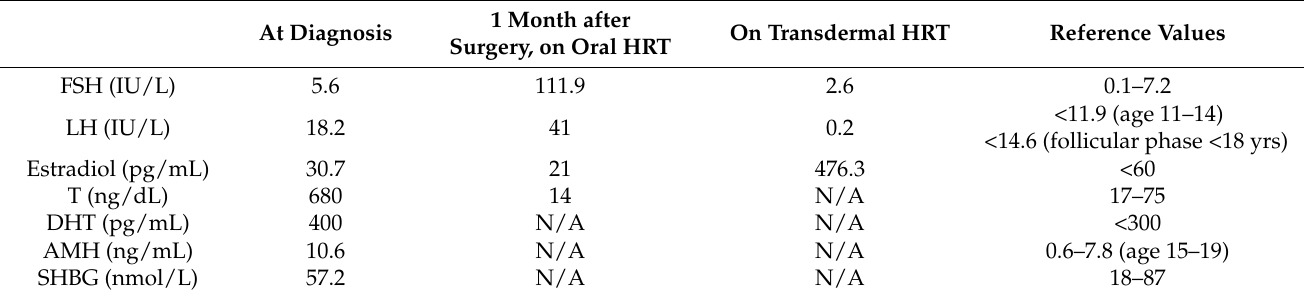
Table 1. Hormonal evaluation markers at diagnosis and on Hormone Replacement Therapy after